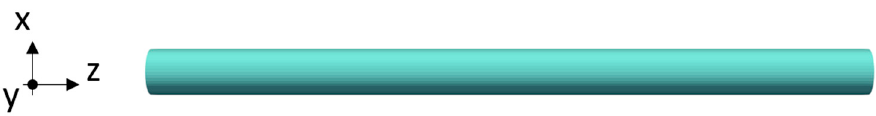
Figure 1. Pipe flow modeled in the present study.